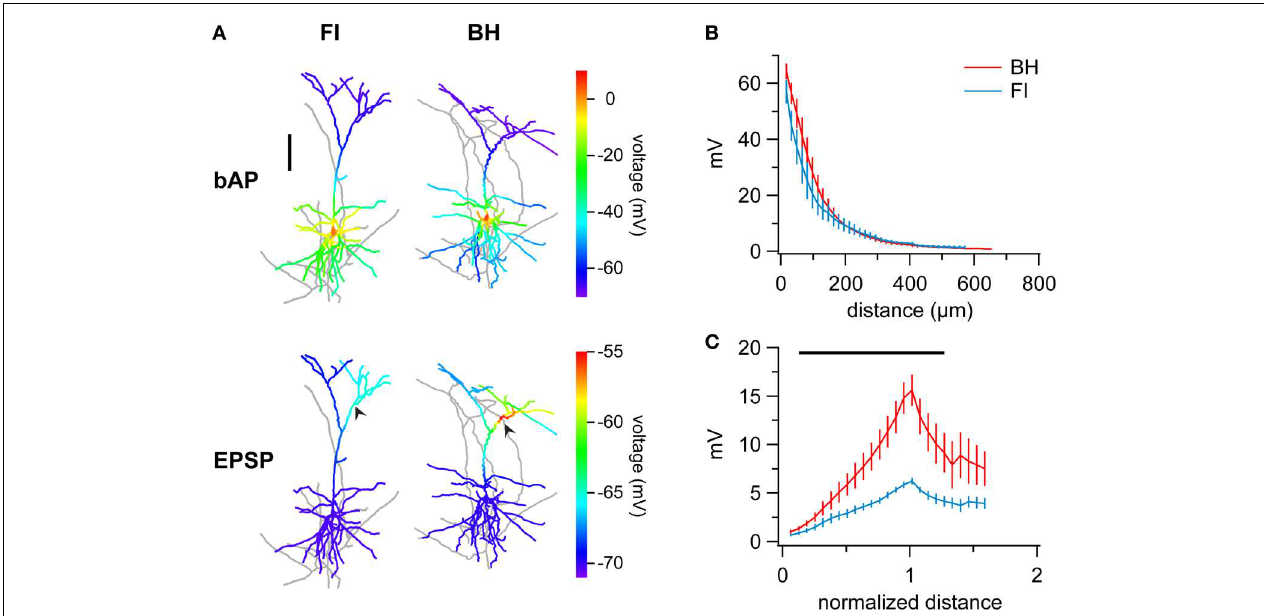
bAPs in PCs reconstructed using FI or BH, measured as peak amplitude at a given distance from the origin of the apical dendrite at the soma. Peak voltages were indistinguishable between methods at all distances. Vertical bars denote ± SEM. (C) Distance-normalized ensemble average of simulated forward-propagating EPSP amplitude in PCs reconstructed with either method shows a striking reduction of depolarizations in FI reconstructions. Distance from soma is normalized to the distance of the simulated synapse. Region of significance is indicated by black bar (paired t -test, p < 0 .